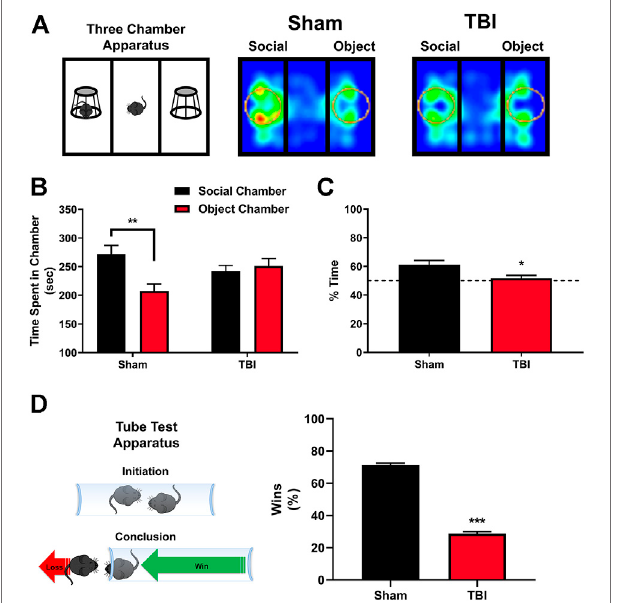
FIGURE 3 | mTBI results in de fi cits in sociability and altered social dominance. (A) DepictionofCrawleythree-chambersociabilityapparatusand representative heatmaps of sham and mTBI subjects ten days post-injury. mTBI subjects exhibit a reduction in interaction time with a novel conspeci fi c,indicativeofareductioningeneralsociability. (B) Quanti fi cationof total time spent in the respective social chamber as compared to object chamber by sham or mTBI subjects. Sham mice exhibit a clear, signi fi cant preference for time spent in the social chamber containing a novel, gender, andage-matchedconspeci fi csubject[F(1,32)=7.47, p ≤ 0.01,N=10Sham, 8 TBI, post hoc analysis (t = 3.57, ** p ≤ 0.01], in stark contrast to mTBI subjectswhichfailtoelicitanypreferenceforthesocialinteraction chamberas compared to the object chamber ( t = 0.45, n. s.) 10 days post-injury. (C) Quanti fi cation of percent time spent speci fi cally within the social interaction zone(depictedascircleswithinapparatusin3A)withthenovel,conspeci fi cby sham and mTBI subjects 10 days post-injury. mTBI subjects fail to exhibit a signi fi cantsocialinteractionzonepreference,whereasshamsubjectsexhibita clear social preference ( t =2.53, * p ≤ 0.05). (D) In concordance withde fi cits in sociability, the tube test for social dominance (depiction included) revealed a signi fi cantdecrease in social dominance behavior 10 days post-injury in mTBI subjects (Fisher ’ s exact test, *** p ≤ 0.001, N = 15/group) when compared to their sham counterparts.